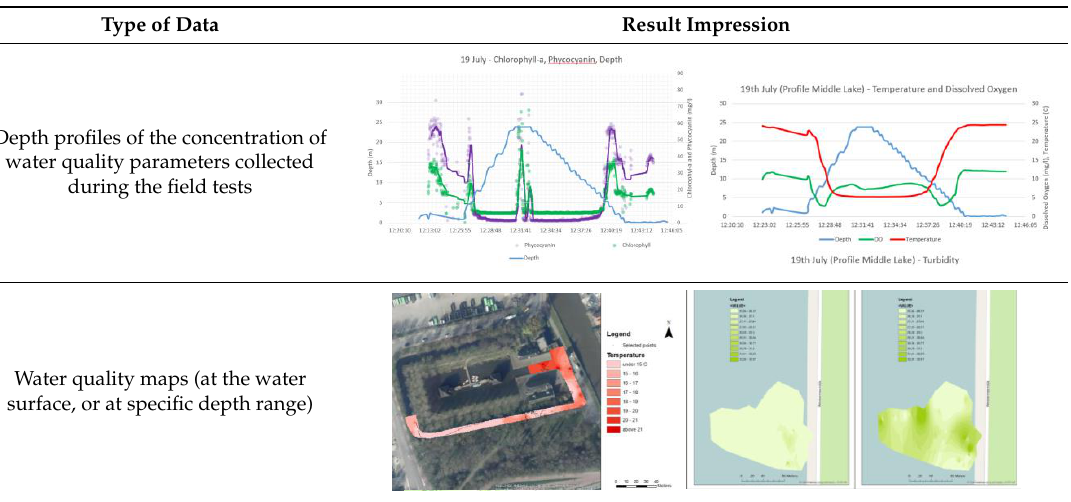
Table 6. Examples of different types of data collected during the measurement campaigns using underwater drones equipped with cameras and sensors.